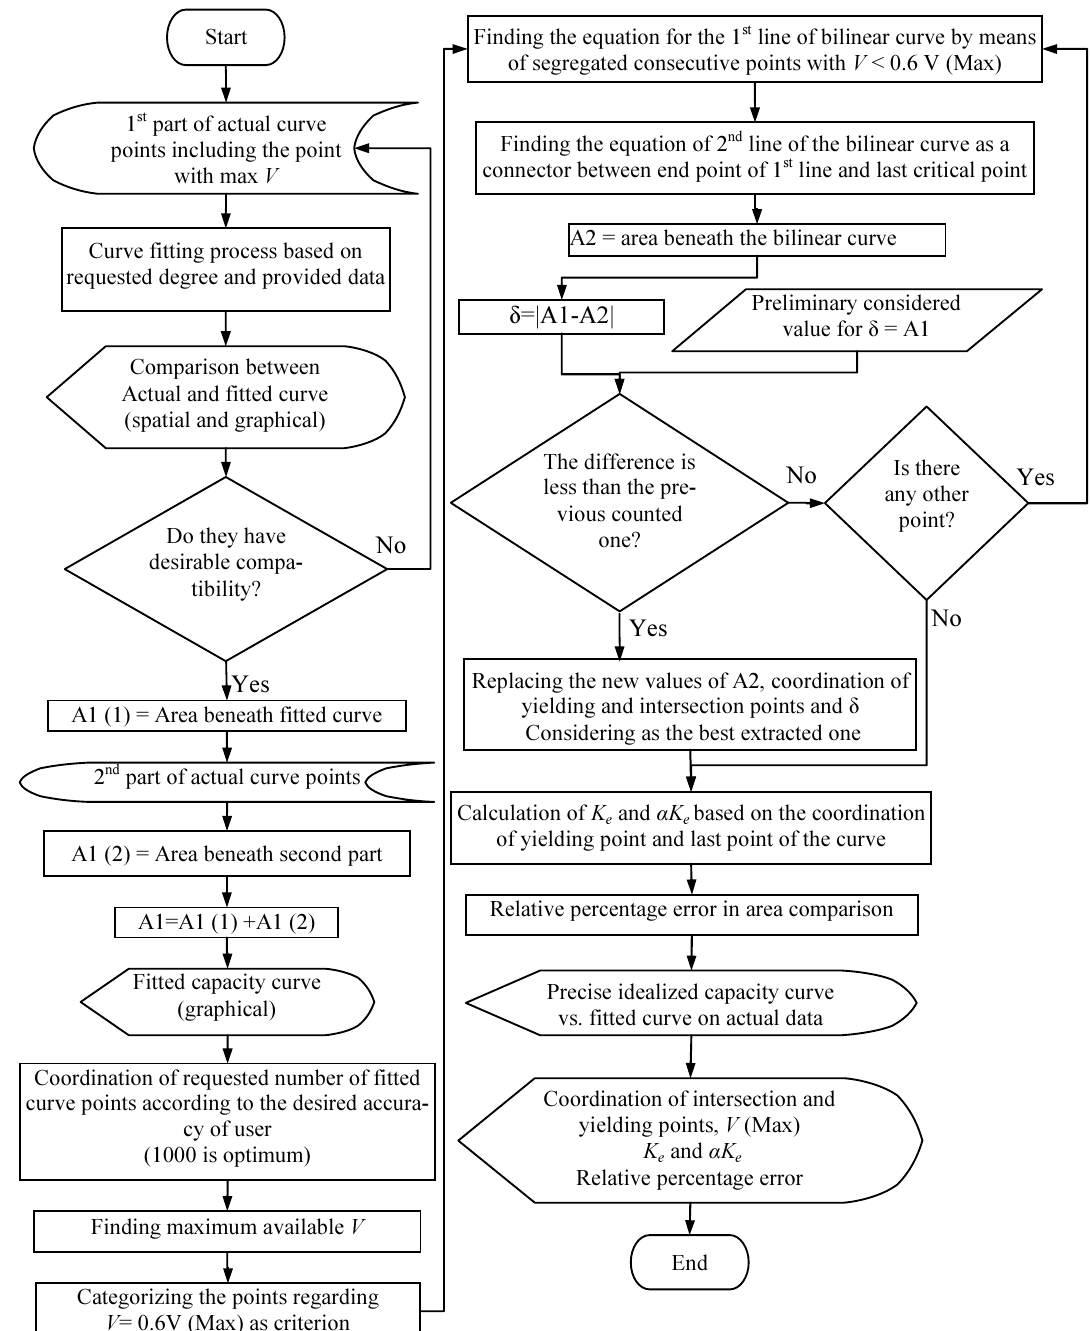
Fig. 5. Flow chart of the developed program for precise bilinearization